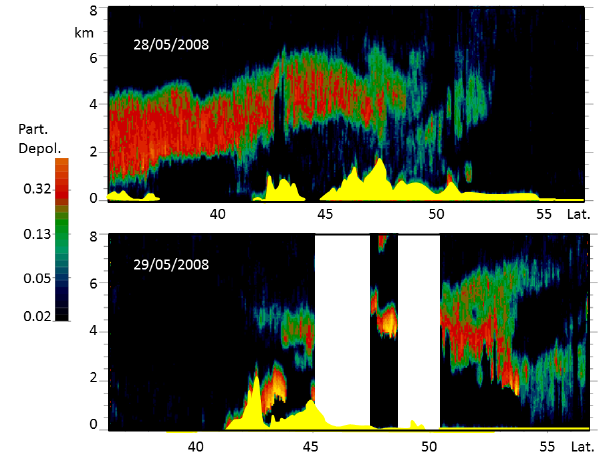
Figure 4. CALIPSO particle depolarization at 532nm for the over- pass at 01:22–01:27UTC on 28 May 2008 (top) and the overpass at 02:00–02:06UTC on 29 May 2008 (bottom). The CALIPSO over- passes on 28 and 29 May 2008 are indicated by the gray line in Fig. 1a and b respectively. The topography is depicted in yellow. The data noised by the high clouds were removed to the picture (blank area).